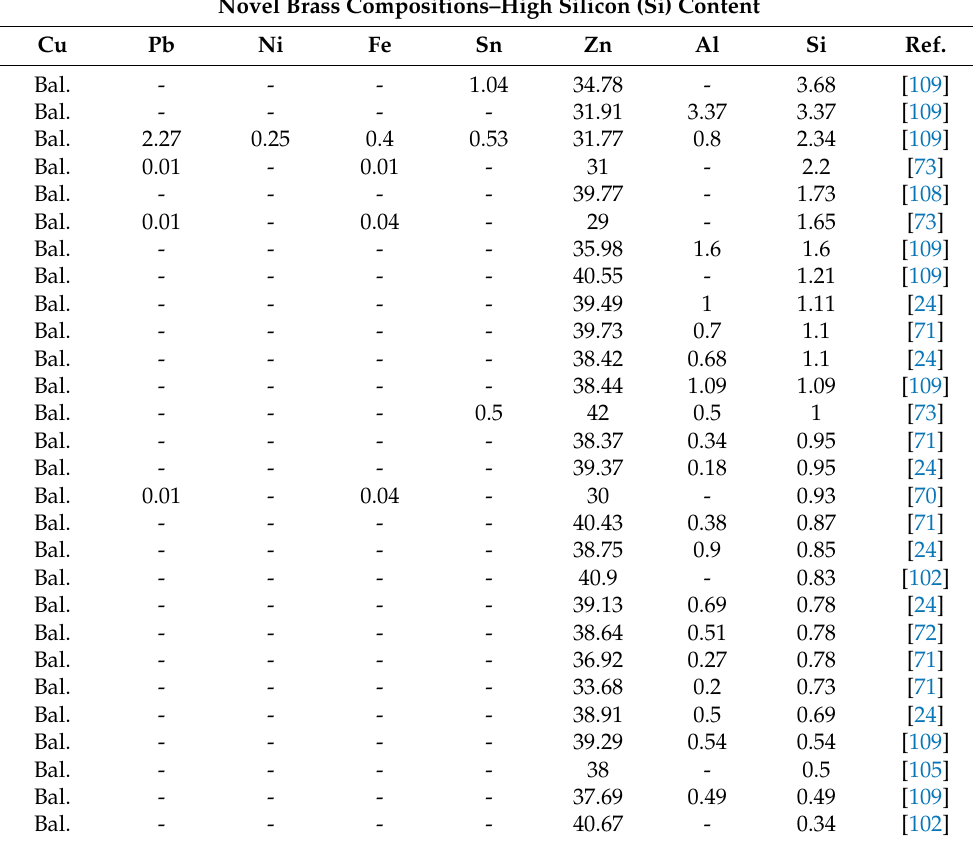
Table A8. Novel brass compositions with an increased silicon (Si) content (alloying elements ex- pressed in